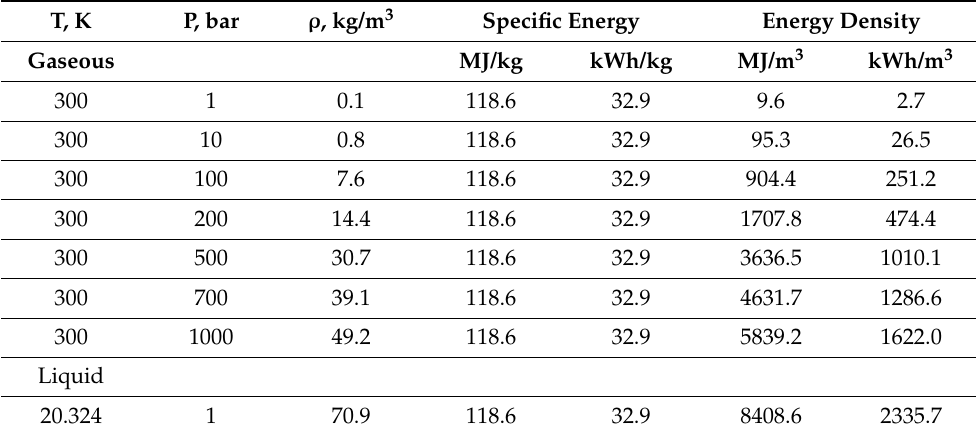
Table 5. Hydrogen properties relevant to ES